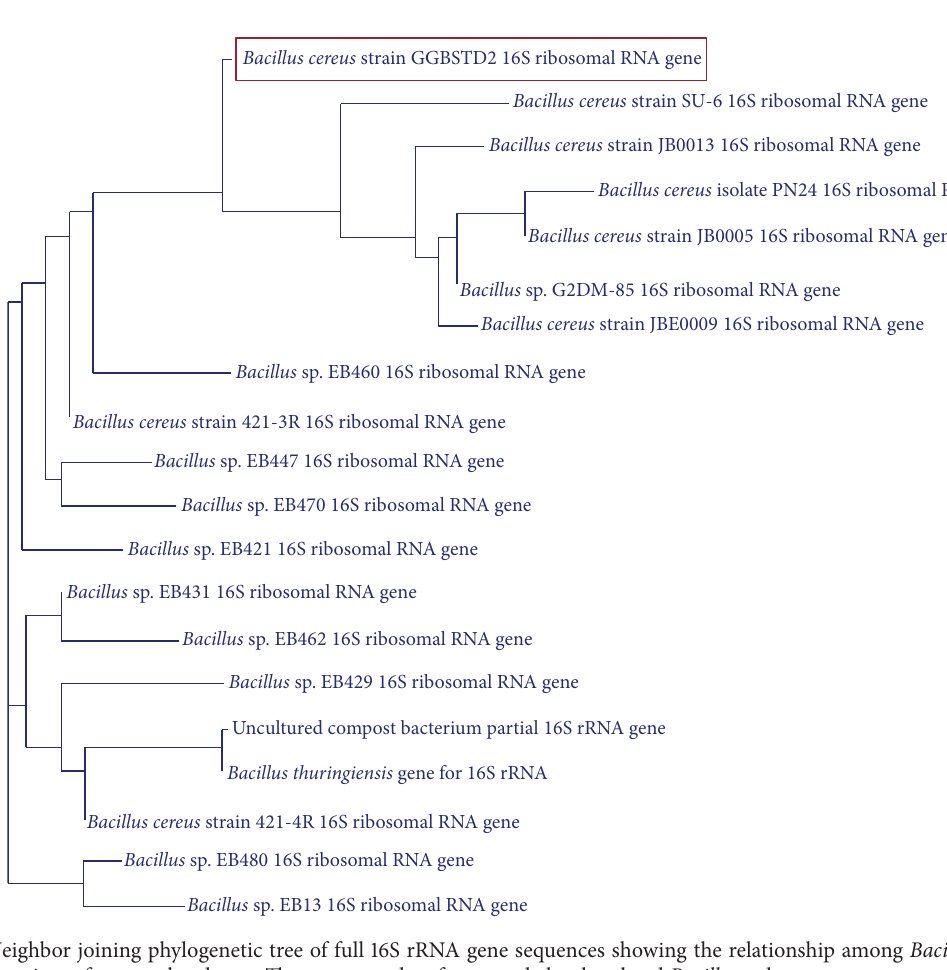
Table 2: The phosphate solubilizing activity, phytohormone (IAA) production, and siderophores production of the bacterial isolates. Name of the organism Phosphate solubilization index (SI) IAA production ( 𝜇 g/mL) a Siderophores production b Bacillus spp. 38.55 24.2 +++ Alcaligenes spp. 29.30 14.7 − Erwinia spp. 28.90 + Serratia spp. 30.45 Pseudomonas spp.